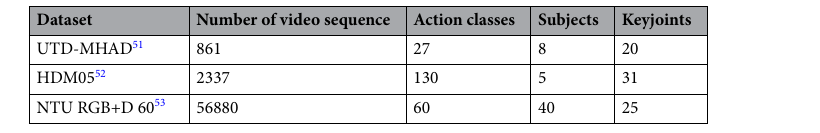
Table 1. Specifications of the different datasets used in the present